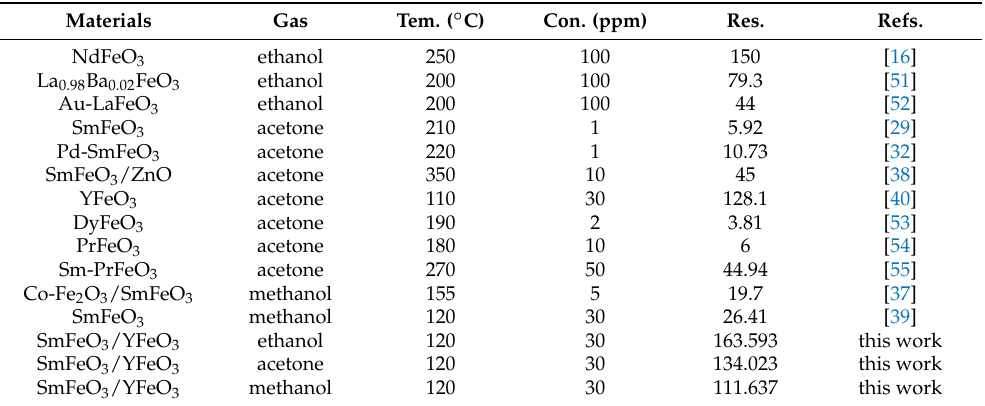
Table 1. Comparison of gas-sensing performance between SmFeO 3 /YFeO 3 (0.4:0.6) sensor and other perovskite sensors.